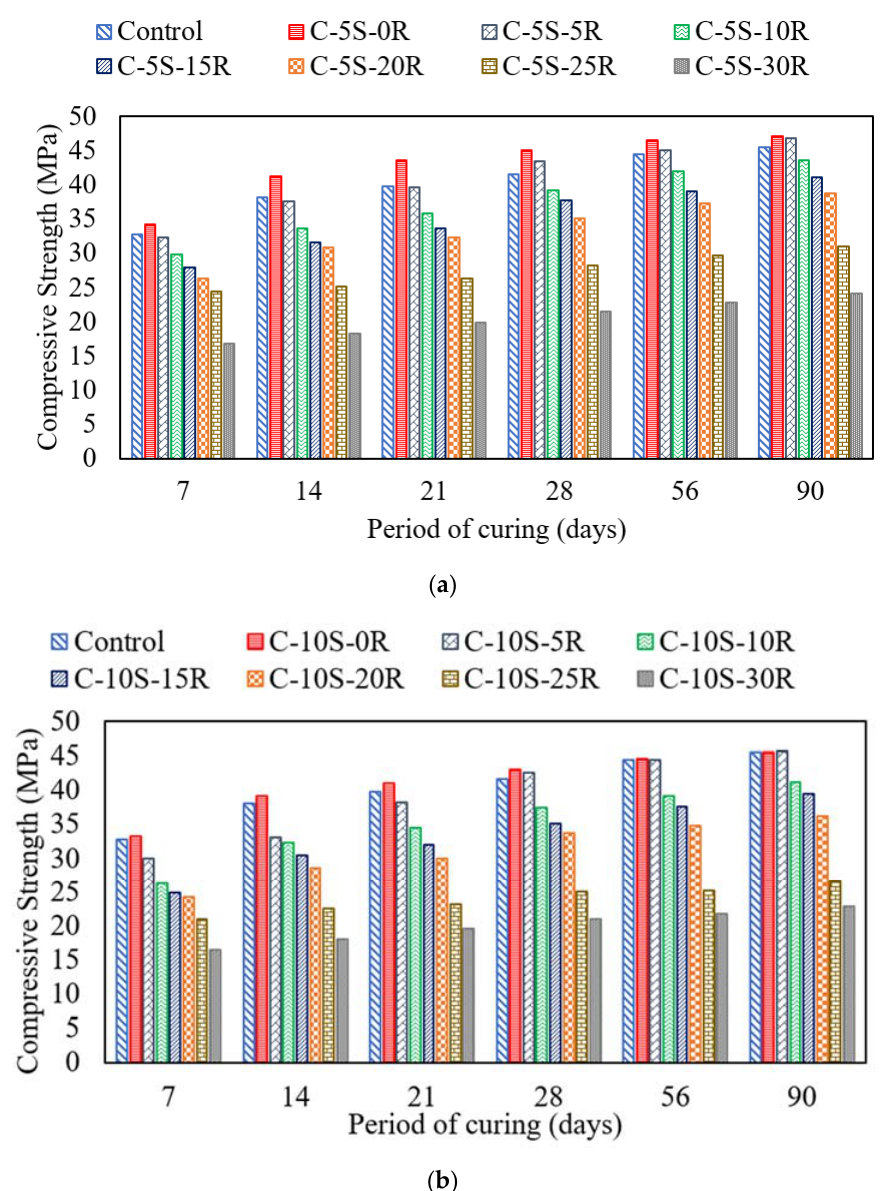
Figure 5. Compressive Strength for specimen incorporating various proportions of SF and RHA. ( a ) C ‐ 5S ‐ (0 to 0)R, ( b ) C ‐ 10S ‐ (0 to 30)R.